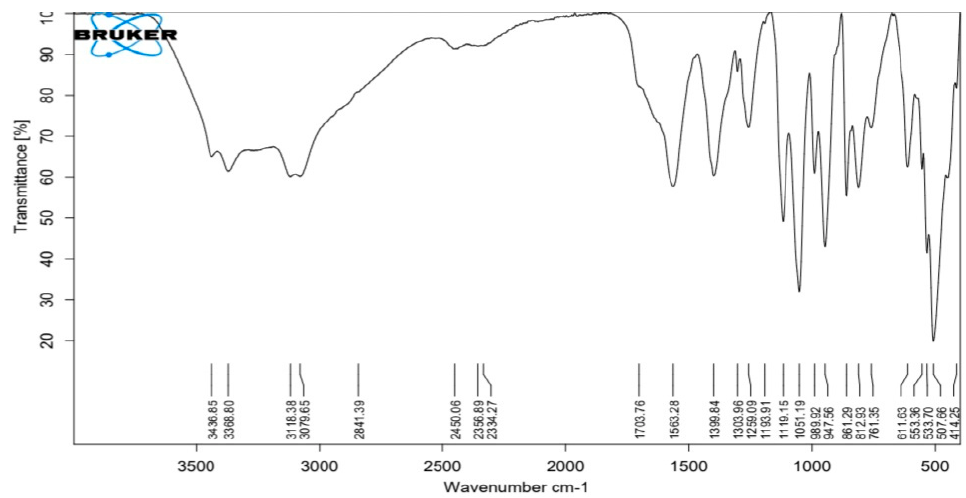
Figure 4. ATR − FTIR of silver nanoparticles biologically prepared with Emericella dentata filtrate.